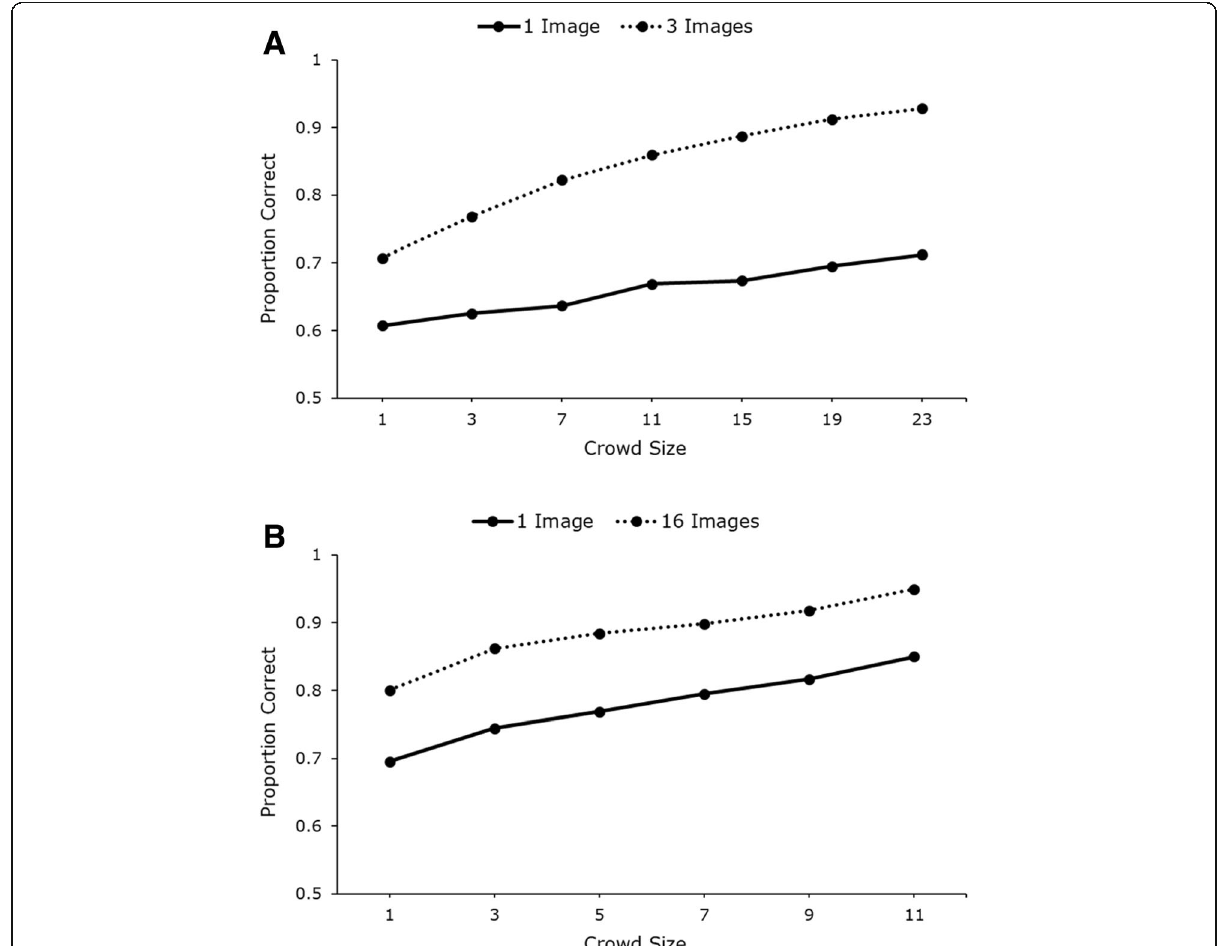
Fig. 9 Crowd analyses on data from studies 1 ( a ) and 2 ( b ) presented separately for trials with one image and with many images. As each point represents the average performance of 14,000 (or 20,000 in study 2) randomly sampled groups of participants (1000 groups per target identity), standard error bars would lie within the marker point and are therefore not represented on the graph. In study 1, mean standard error = 0.004 for 1-image trials and mean standard error = 0.003 for 3-image trials. In study 2, mean standard error = 0.003 for 1-image trials and mean standard error = 0.002 for 16-image